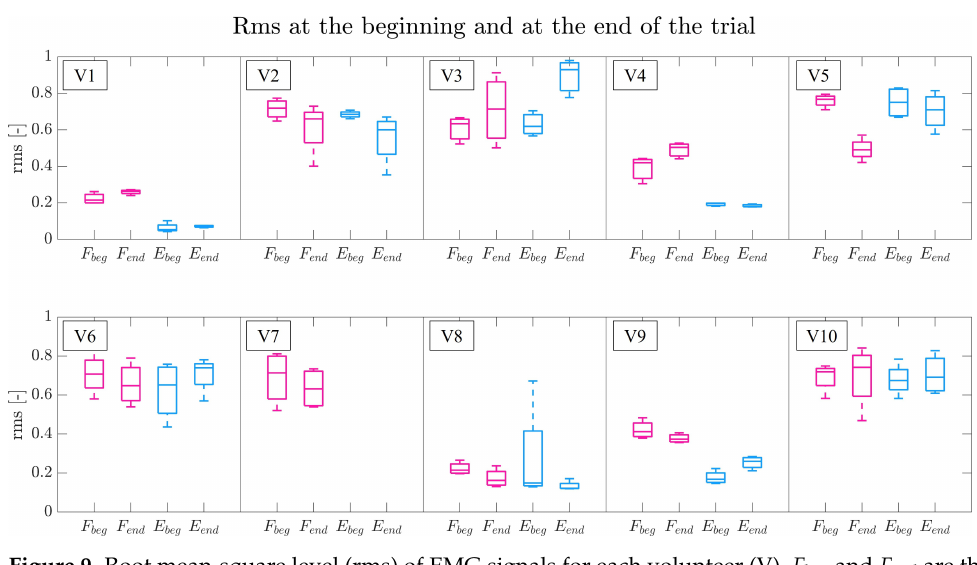
Figure 8. Boxplot of the average communal P and average communal TE for the three waveforms at each level of complexity. The central line is the median of the scores of the 10 volunteers in each one-minute repetition for every level of complexity, the edges of the box are the 25th and 75th percentiles, and the whiskers extend to the most extreme data points not considered outliers.